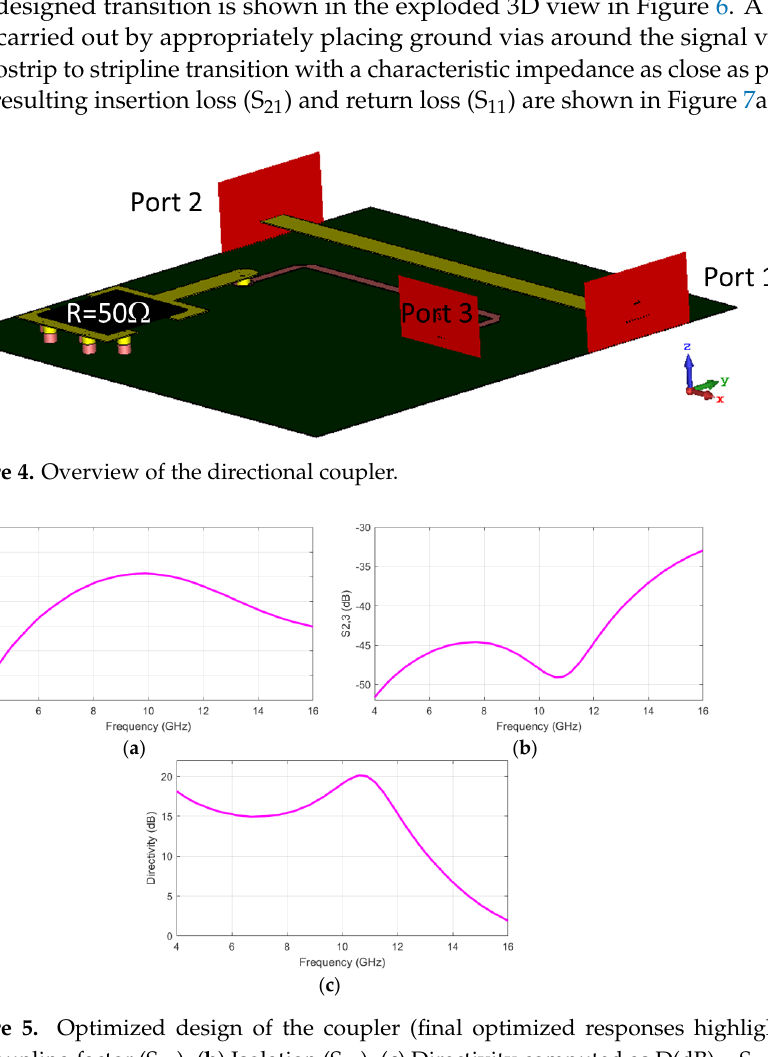
Figure 5. Optimized design of the coupler (final optimized responses highlighted in purple). ( a ) Coupling factor (S 13 ). ( b ) Isolation (S 23 ). ( c ) Directivity computed as D(dB) = S 13 (dB) − S 23 (dB).